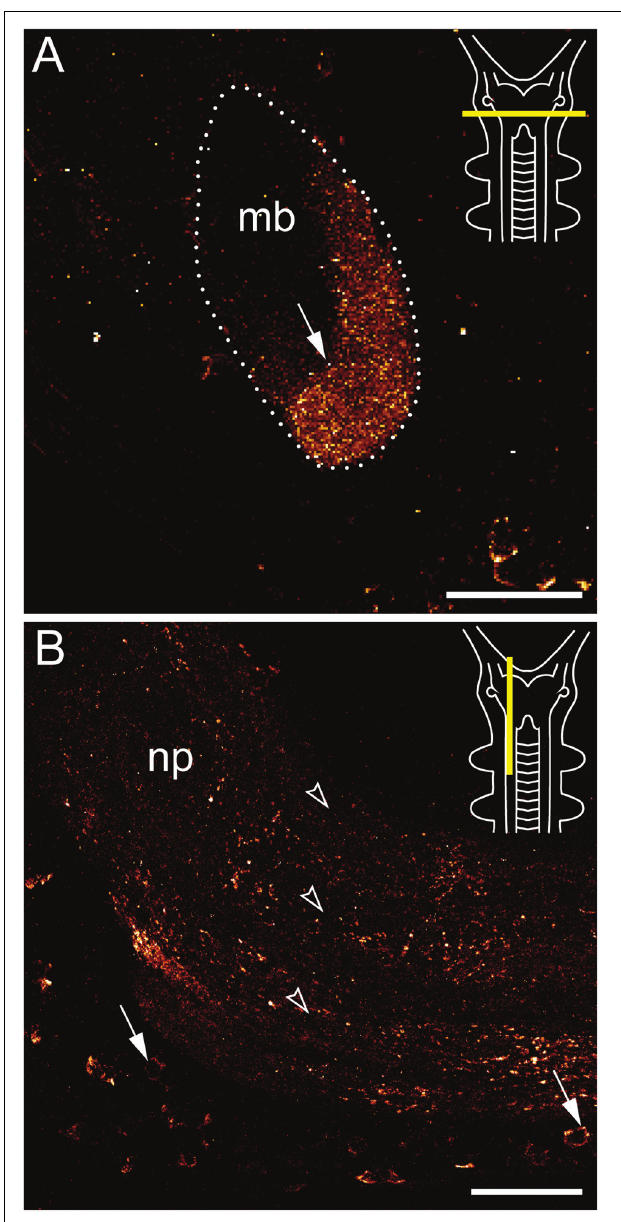
FIGURE 4 | Immunolocalization of arthropsin in the nervous system of the onychophoran Euperipatoides rowelli. Vibratome sections of heads. Confocal micrographs. Dorsal is up in all images. Insets in the upper right corners illustrate the position of sectional planes (yellow bars). (A) Cross section of the mushroom body. Note the presence of immunoreactive fibers in the inner/median lobe (arrow). (B) Sagittal section of anterior nerve cord. Note the immunoreactive somata (arrows) within the perikaryal region and fibers within the nerve cord neuropil (arrowheads). Abbreviations: mb, mushroom body; np, nerve cord neuropil. Scale bars: 50 µ m (A,B)